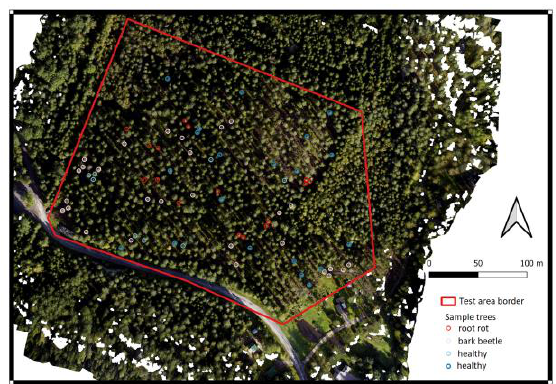
Figure 1. The test area and the trees used in the